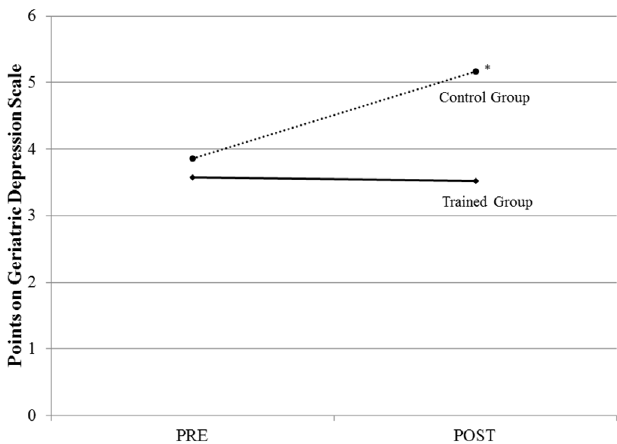
Figure 1. Mean and standard deviation of the scores on GDS-15 by the control and trained groups; *Between-subject effect F Figure 2. Mean and standard deviation of (A) time taken to complete the TUG and; (B) the score on Berg’s FBS by both groups (control and trained groups); * p = .05.